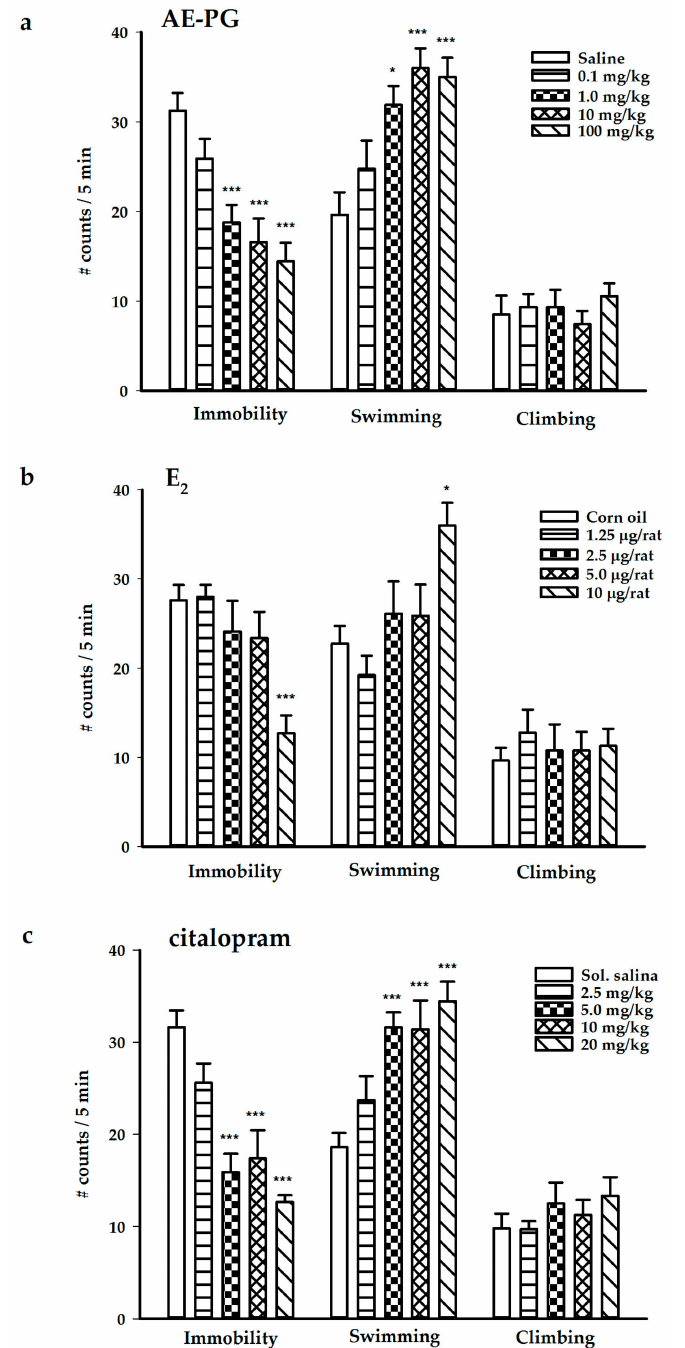
Figure 1. Behavioral effects produced by the chronic administration (14 days; one administration per day) of the AE-PG (panel ( a ); n = 7–9 per dose), E2 (panel ( b ); n = 7–8 per dose), and citalopram (panel ( c ); n = 8–10 per dose) on the forced swimming test. The figure shows the mean number of counts ± standard error. Dunnett post hoc: * p < 0.05; *** p < 0.001 versus the control group. AE-PG = aqueous extract of pomegranate; E2 = 17 β